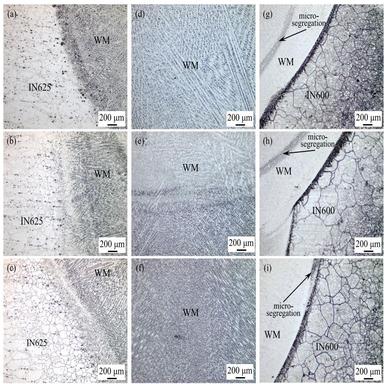
OM images of the IN625/WM/IN600 welded joint (top) cap pass, (center) intersection of the root-cap passes, and (bottom) root pass.